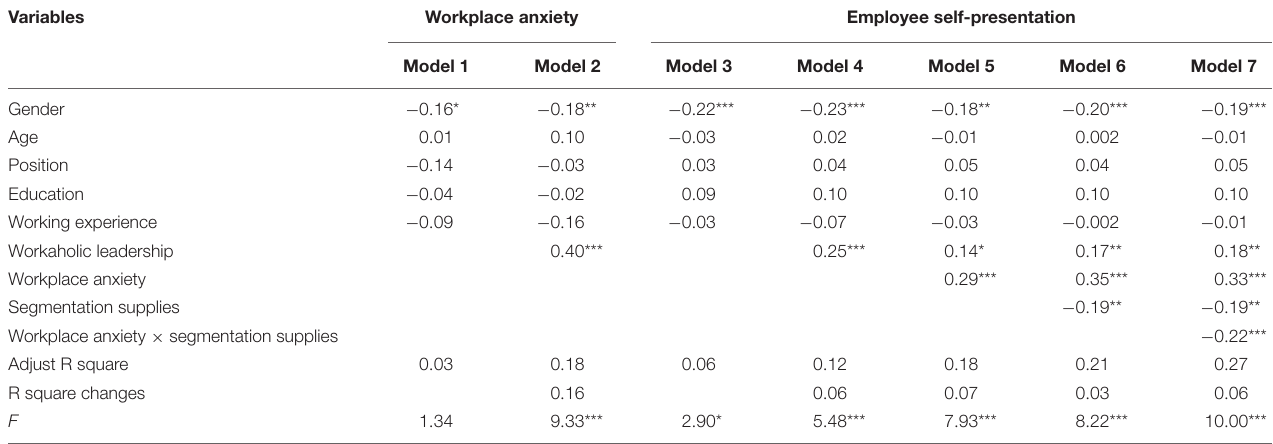
TABLE 3 | Hierarchical regression test of mediating and moderating effects.